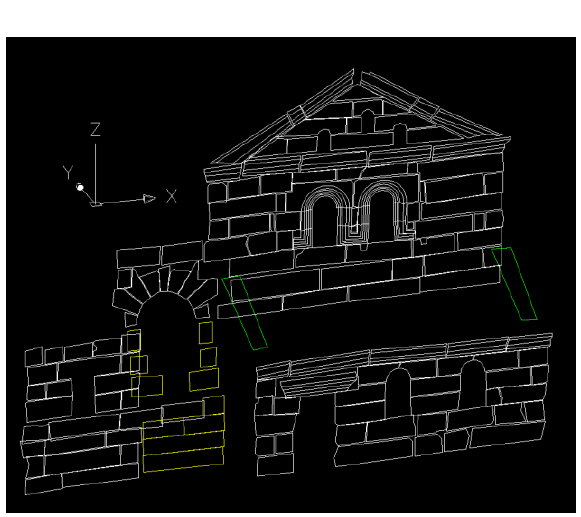
Figure 17 – Serjilla (Plot by E.Cingolani with two